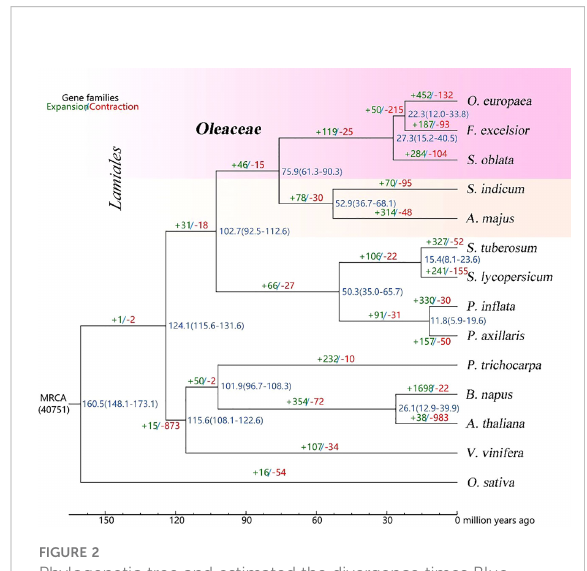
FIGURE 2 Phylogenetic tree and estimated the divergence times Blue numbers on the nodes are divergence time to present (in